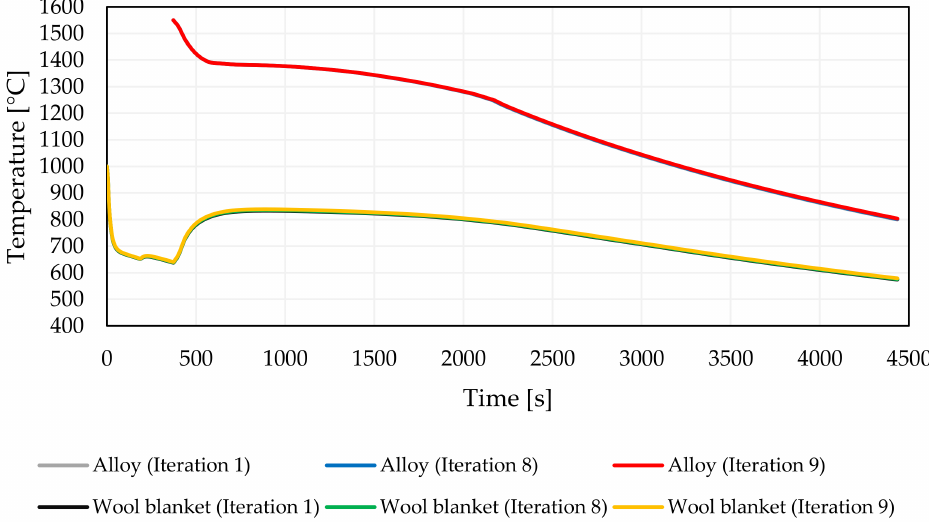
Figure 16. Evaluation of the influence of emissivity on the alloy and wool blanket temperature